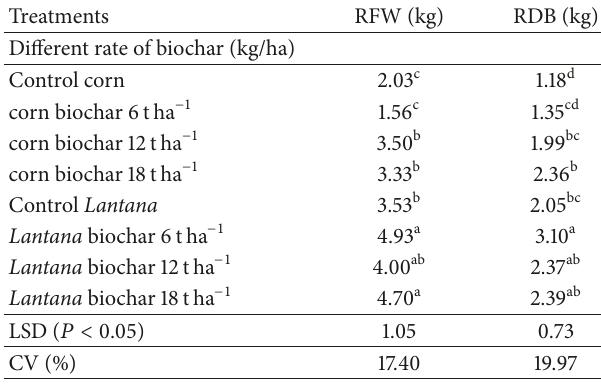
Table 4: Mean root length, root fresh weight, and root dry biomass of pea as influenced by different rate of biochar at